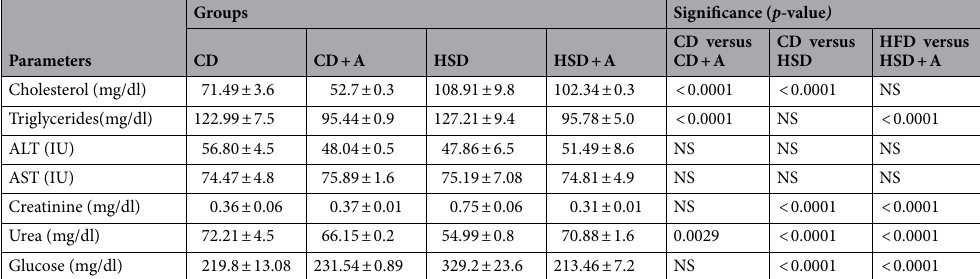
Table 2. Short term effect high salt (4% in chow) diet followed by Amoxicillin treatment on biochemical parameters in mice. Values are expressed as the means ± SD. Data were analyzed by one-way ANOVA, followed by Bonferroni test, n = 6, p ≤ 0.05, NS = Not significant, CD: Standard—chow diet for 3 weeks; CD + A: Standard—chow diet for 3 weeks and subjected to Amoxicillin treatment in 3rd week; HSD: High-salt diet for 3 weeks; HSD + A: High-salt diet for 3 weeks and subjected to Amoxicillin treatment in 3rd week.